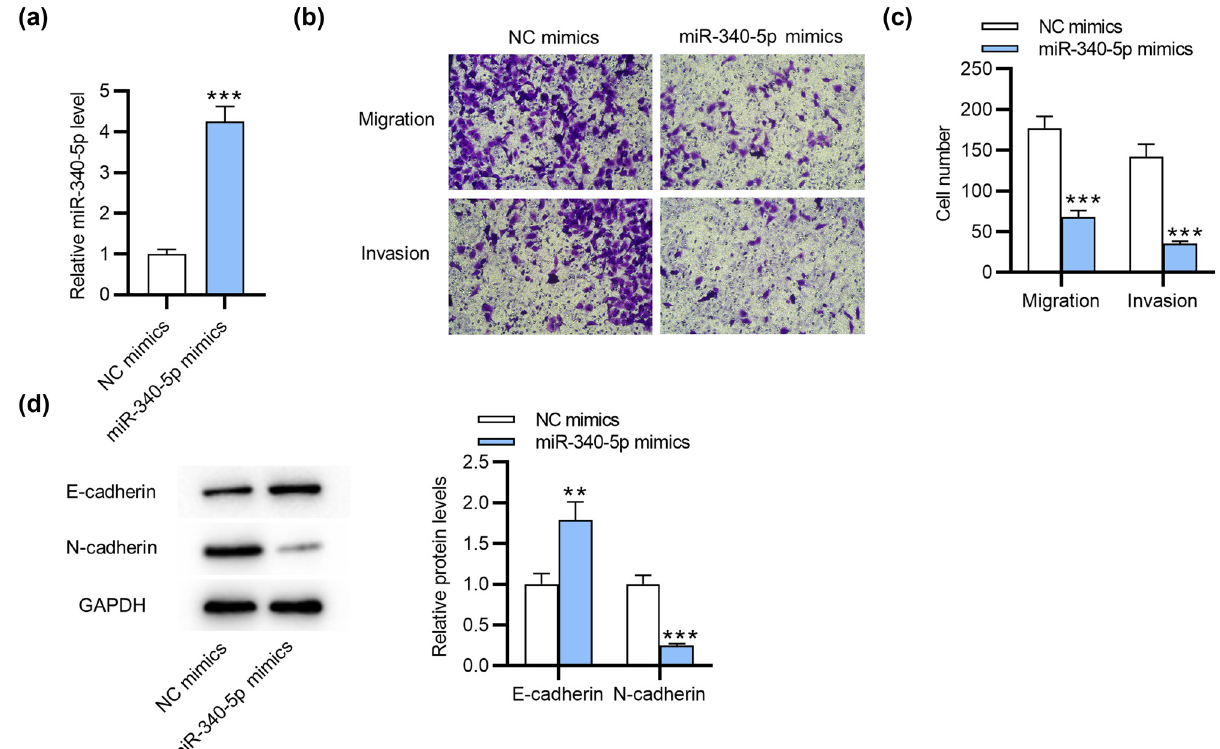
Figure 1: miR - 340 - 5p restrains cell migration, invasiveness and EMT in endometriosis. ( a ) RT - qPCR for the transfection e ffi ciency of miR - 340 - 5p mimics in ESCs. ( b and c ) Transwell assays for evaluating ESC migratory and invasive abilities after overexpressing miR - 340 - 5p. ( d ) Western blotting for assessing protein levels of EMT - associated markers ( E - cadherin and N - cadherin ) . ** p < 0.01, *** p <